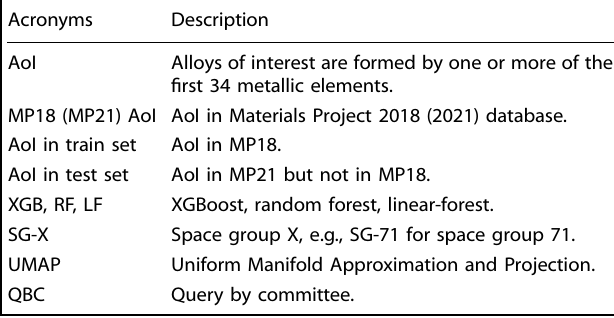
Table 1. List of important acronyms used in this work.